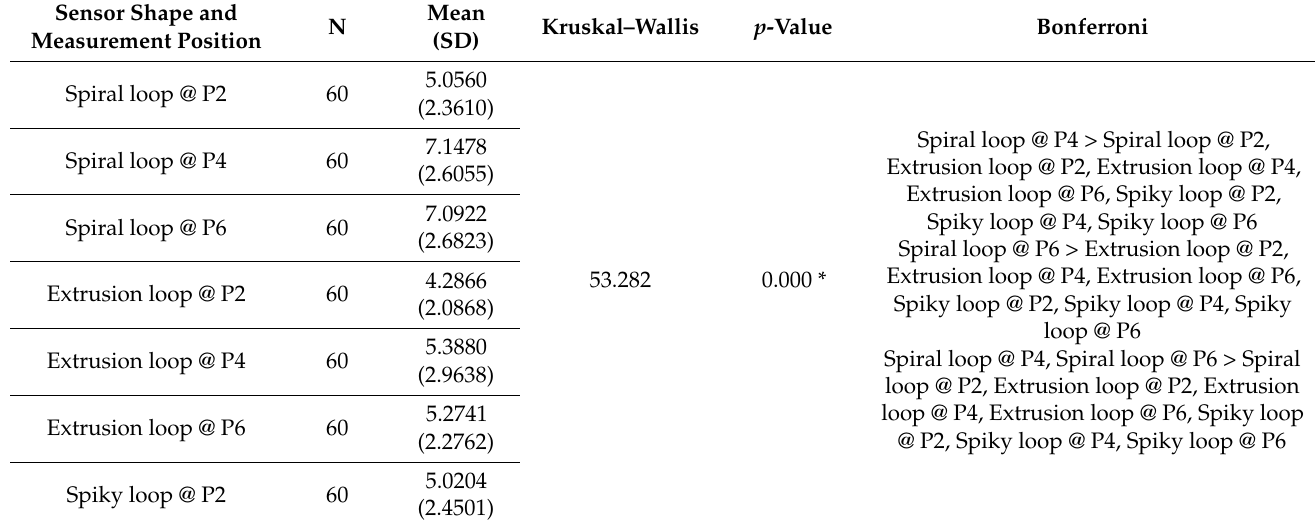
Table 2. Efficiency evaluation of cardiac activity signals according to the sensor shape and measure- ment